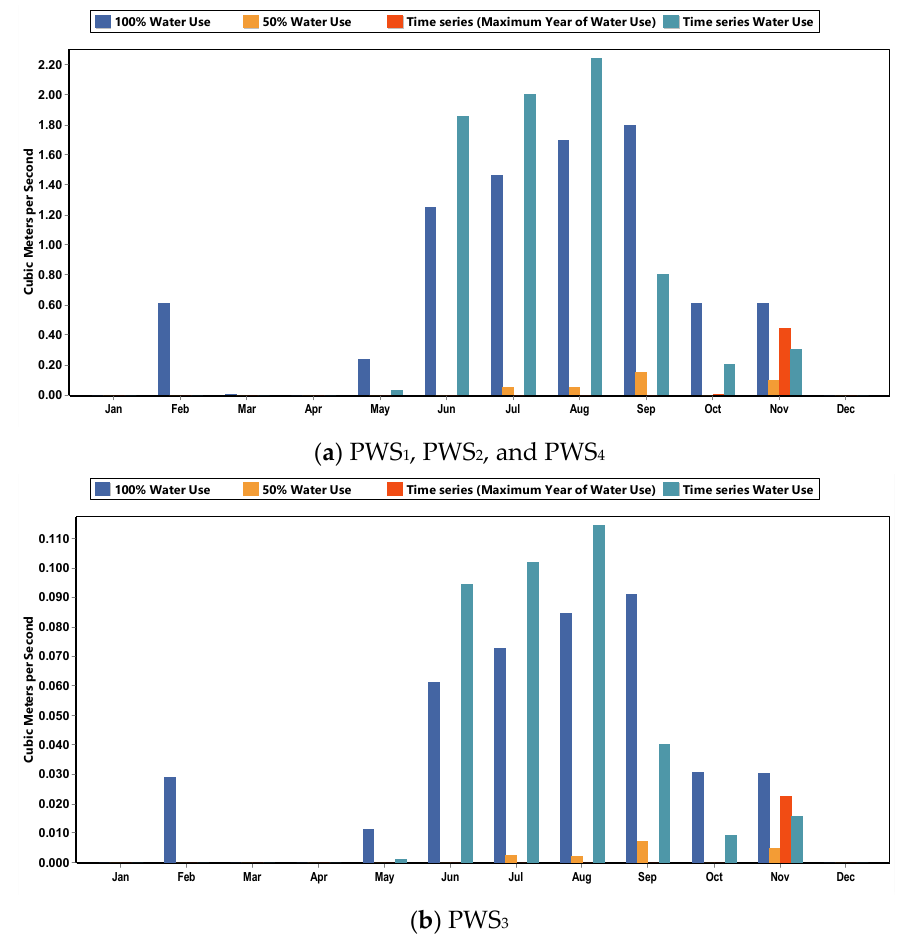
Figure 19. Average monthly unmet demand (m 3 /s) for public water supply (PWS) in future scenarios for the period of 2023–2039.